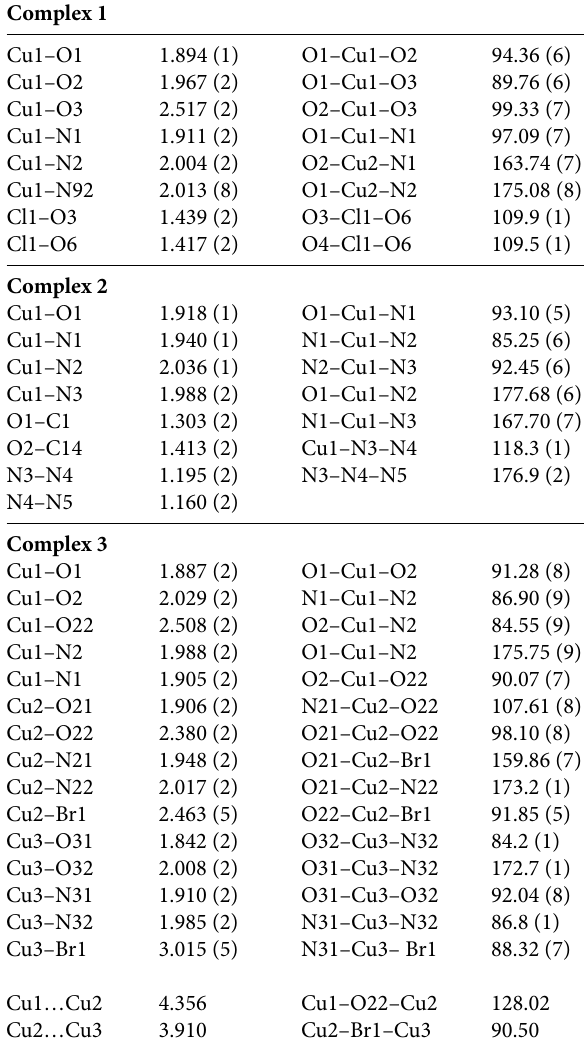
Table 2. Selected bond lengths (Å) and angles (°) in complexes 1 –